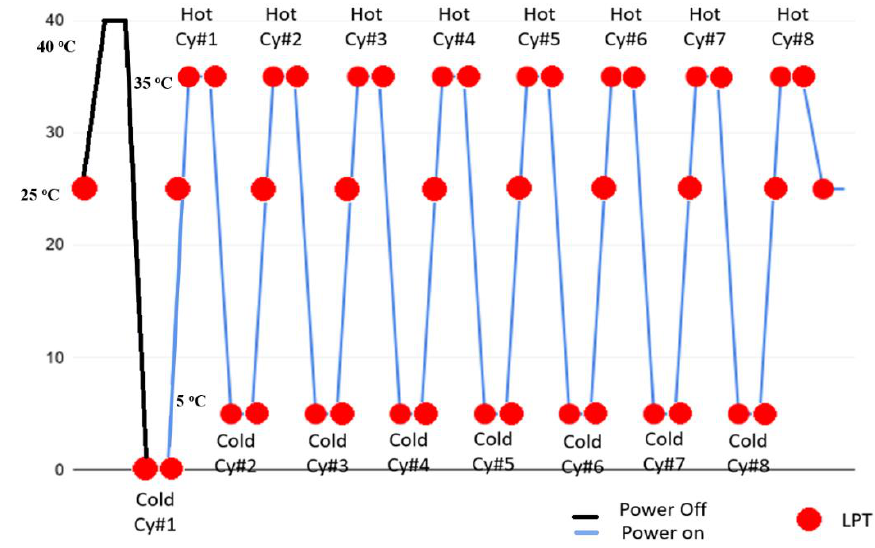
Figure 13. TVC test temperature setting.